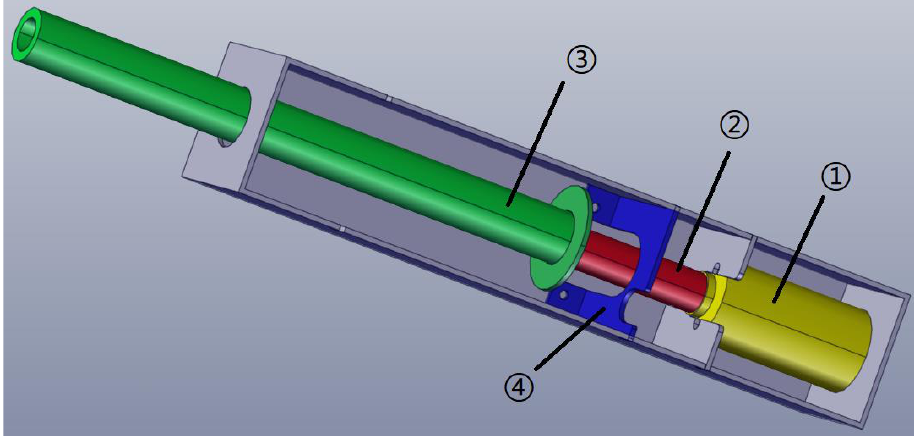
Figure 4. Mechanical structure diagram of the robotic arm. The 1 (cid:13) cylinder in Figure 4 is the BLDC motor. It is fixed to the mechanical arm locking mechanism. The 3 (cid:13) cylinder is an internal thread rod, and the thread pitch is